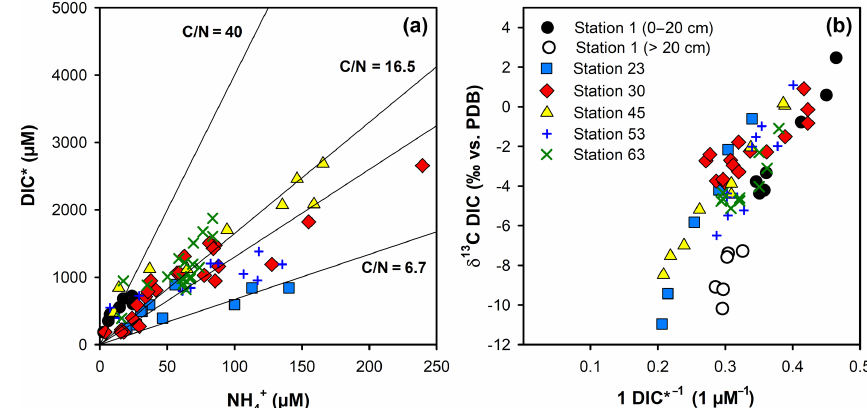
Figure 5. (a) Cross plot of dissolved NH + and pore-water DIC* after correction for bottom-water DIC concentrations. The average pore- 4 water DIC / NH + ratios for the individual stations are shown in Table 2. (b) Keeling plot of the fraction of remineralized DIC calculated 4 from a two-end-member mixing model versus δ 13 C DIC .